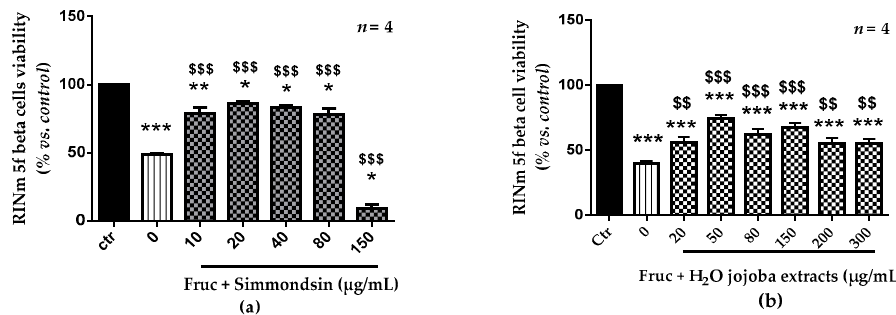
Figure 2. Effect of pure simmondsin ( a ) and the aqueous extract of jojoba seeds ( b ) on viability of RINm5f beta cells in the presence of fructose (250 mM). Each value represents the mean ± standard error of the mean (SEM) of three independent experiments in triplicate. * p < 0.05, ** p < 0.01, *** p < 0.001, compared to untreated cells, * p < 0.05, $$ p < 0.01, $$$ p < 0.001, compared to fructose-treated cells. Fruc: fructose.